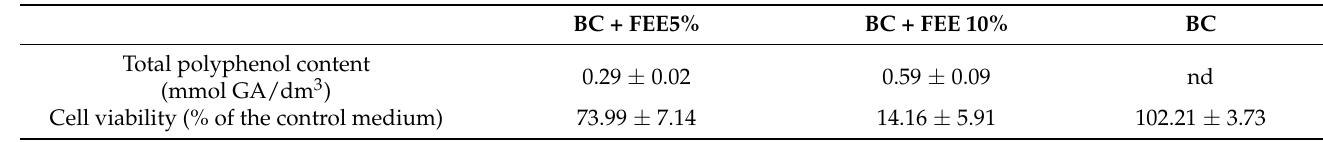
Table 4. The total phenolic content released from BC-5%FEE, BC-10%FEE, and BC to the culture medium and its effect on cell